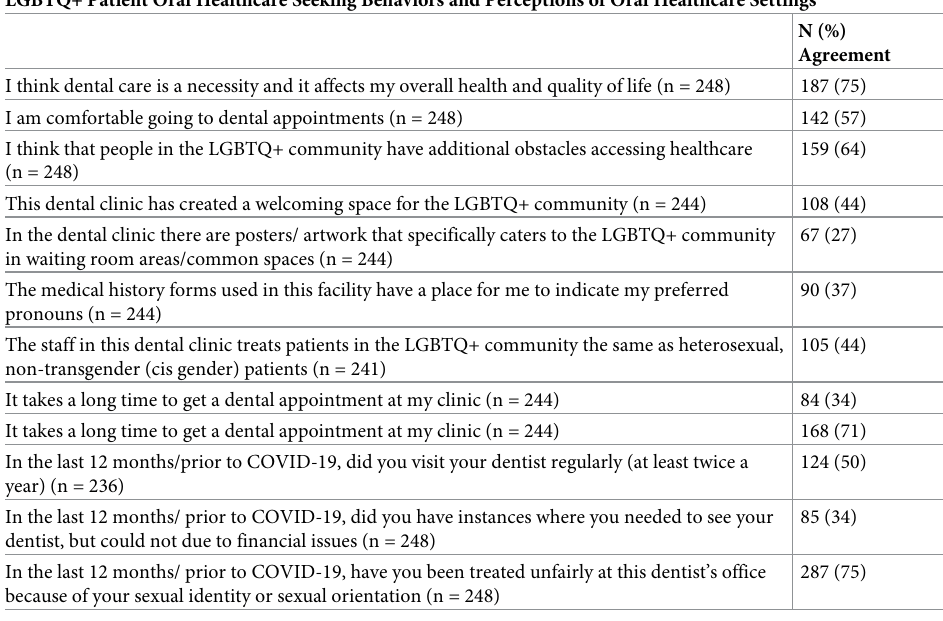
LGBTQ+ Patient Oral Healthcare Seeking Behaviors and Perceptions of Oral Healthcare Settings